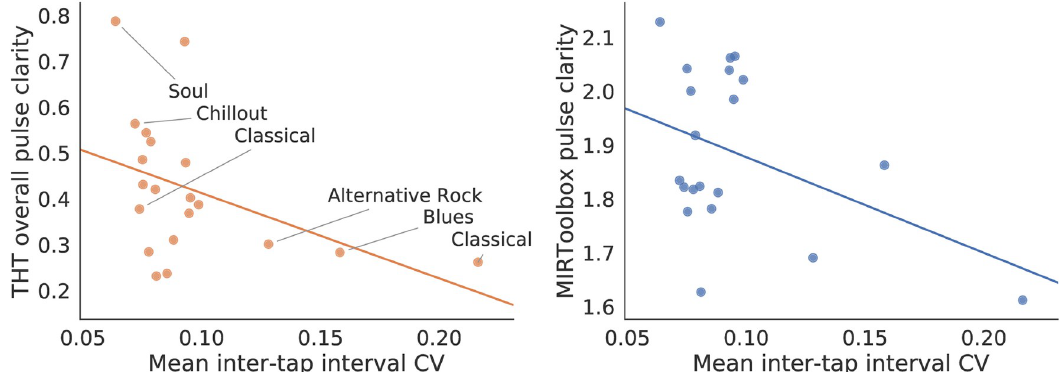
Fig 7. Pulse clarity score compared against tapping variability. Left: THT clarity score is calculated as the mean congruency score of the top hypotheses. Tapping precision is calculated as the mean coefficient of variability of the inter-tap interval distribution. Each point represents one track in the MIREX Beat Tracking training dataset. Spearman correlation has r = − 0.534 ( p = 0.015). Genres of least and most variable tapping scenarios (on average) are annotated in the plot. Right: Pulse clarity score from MIRToolbox [5] compared against tapping variability (Spearman r = − 0.149, p =